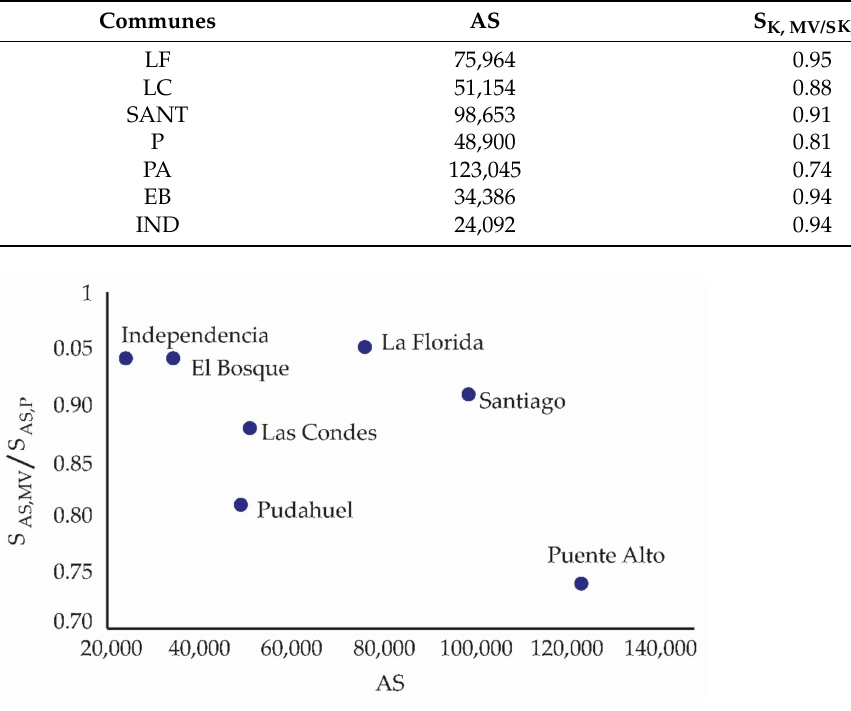
Figure 7. Maximum ratios, between entropies of (accumulated patients)/(meteorological variables) and those of (accumulated patients)/(pollutants), S AS, MV/ S AS, P , versus accumulated sick people (AS). Table 5. Approximate variation of square meters built in five communes of the study [27,28,42] and the accumulated sick people (2020–2022).